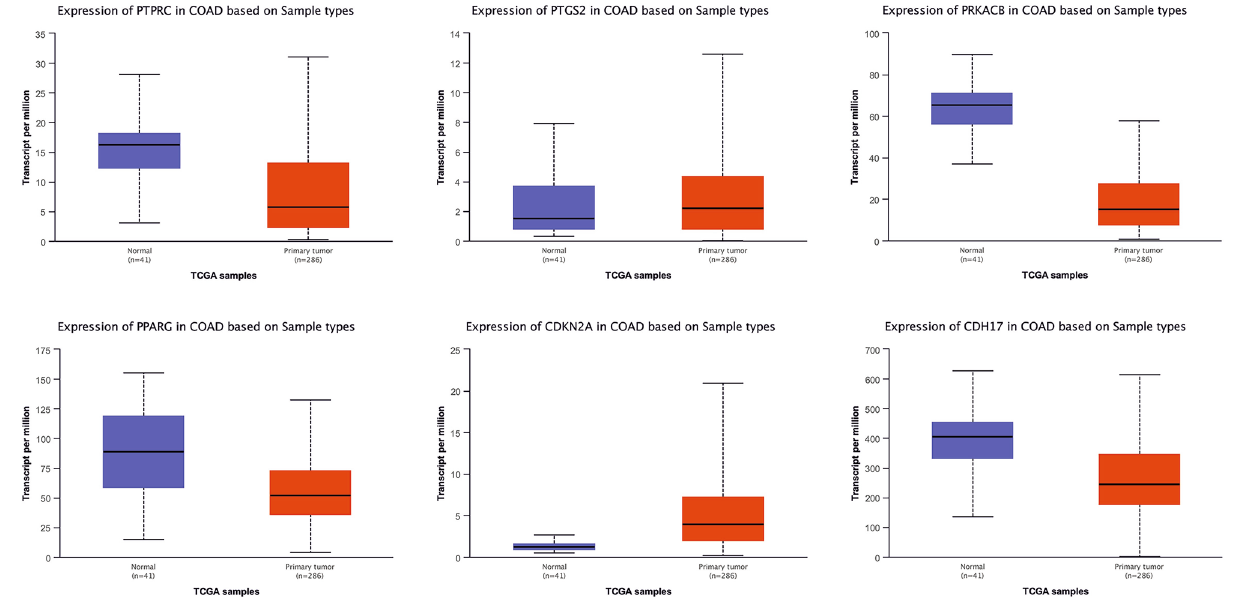
Figure 5. The box-plots show the expression of some of the hub genes with statistically significant differential expression in two normal and tumor groups.